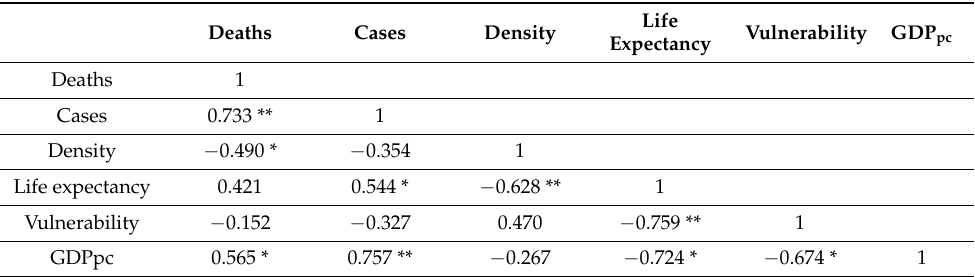
Table 2. Correlation analysis of the different variables.